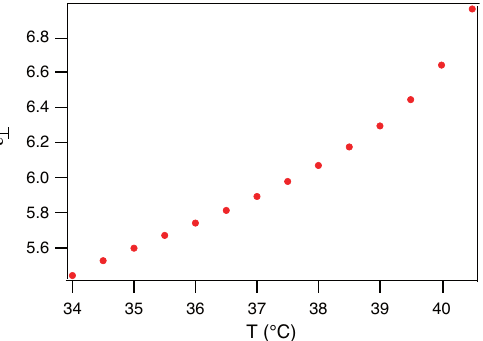
Figure 3. Dielectric constant ε ⊥ measured below the onset of instability in a planar sample of thickness d = 7.5 µ